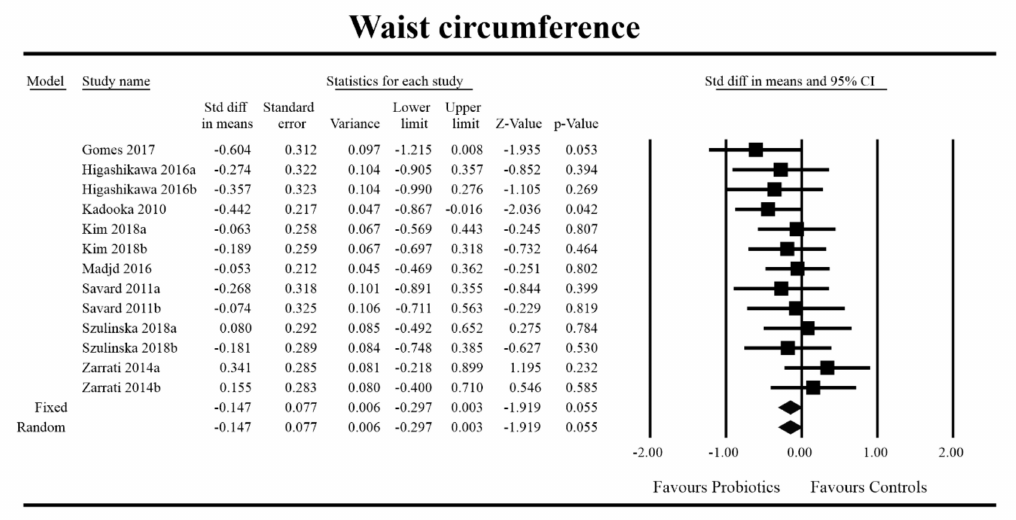
Figure 4. E ff ect size and standardized mean di ff erence for waist circumference (WC) in persons taking probiotics vs. controls (endpoint data). Q = 9.773, df (Q) = 12, p = 0.636, I-squared = 0.0. WC—waist circumference.